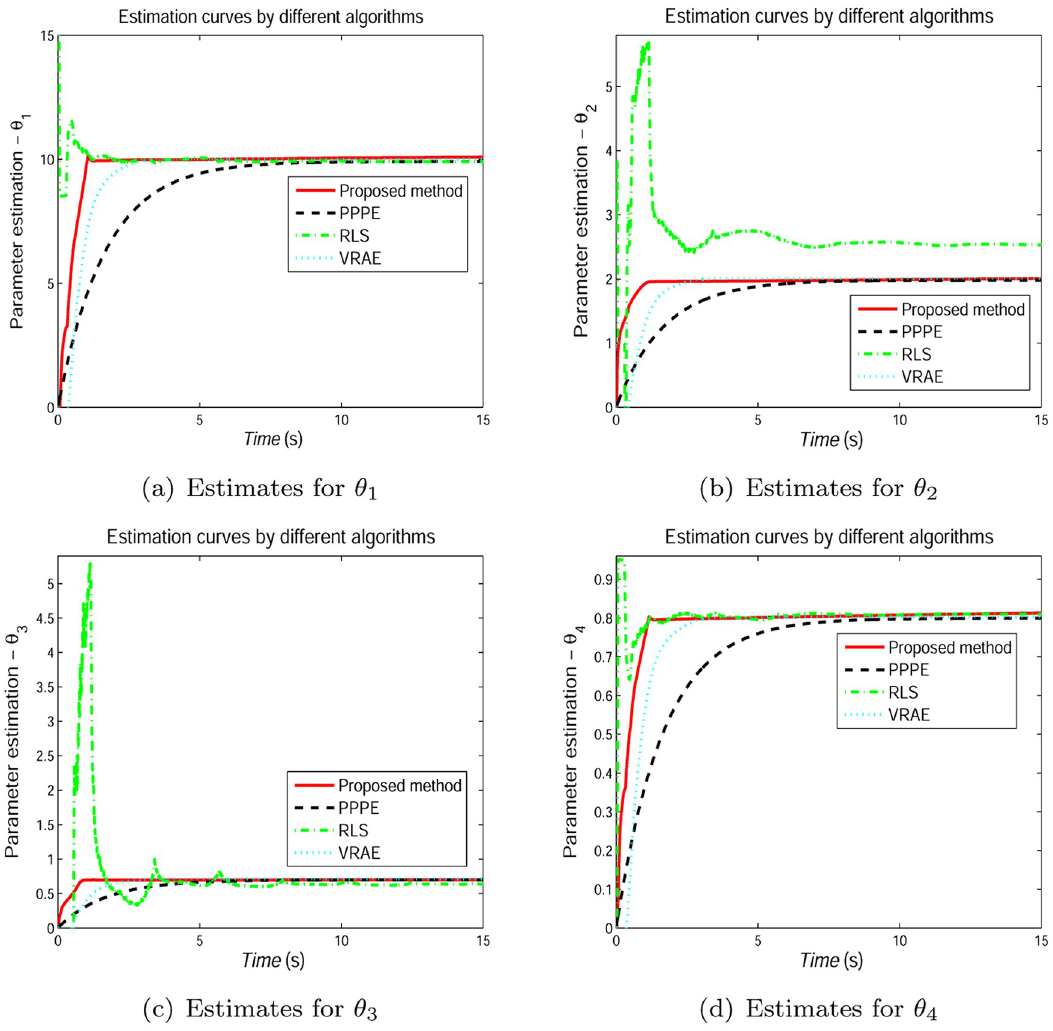
Fig 12. Estimation histories of the system parameters. (a) Estimates for θ 1 . (b) Estimates for θ 2 . (C) Estimates for θ 3 . (d) Estimates for